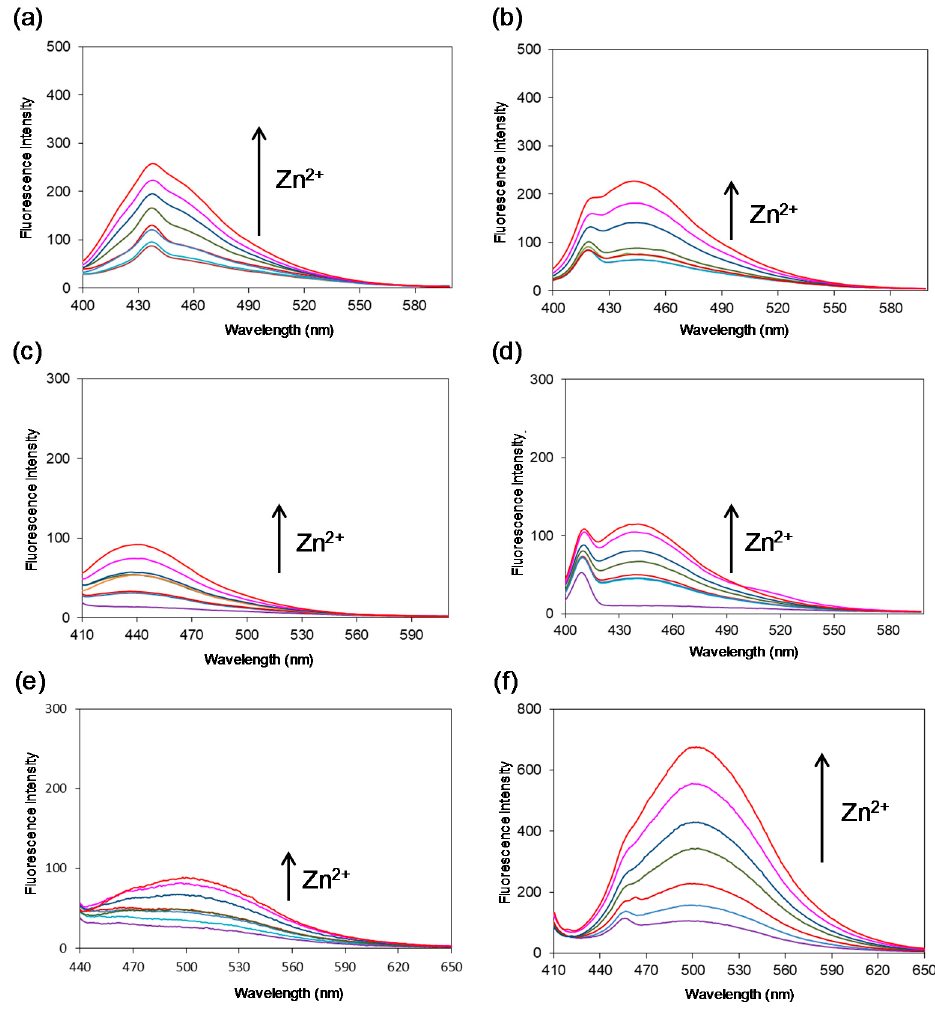
Figure 2. Fluorescence spectra of ( a ) 3a (10 − 5 M, λ ex = 381 nm); ( b ) 3b (10 − 5 M, λ ex = 367 nm); ( c ) 4a (10 − 5 M, λ ex = 353 nm); ( d ) 4b (10 − 5 M, λ ex = 360 nm); ( e ) 5a (10 − 5 M, λ ex = 377 nm); ( f ) 5b (10 − 5 M, λ ex = 395 nm)